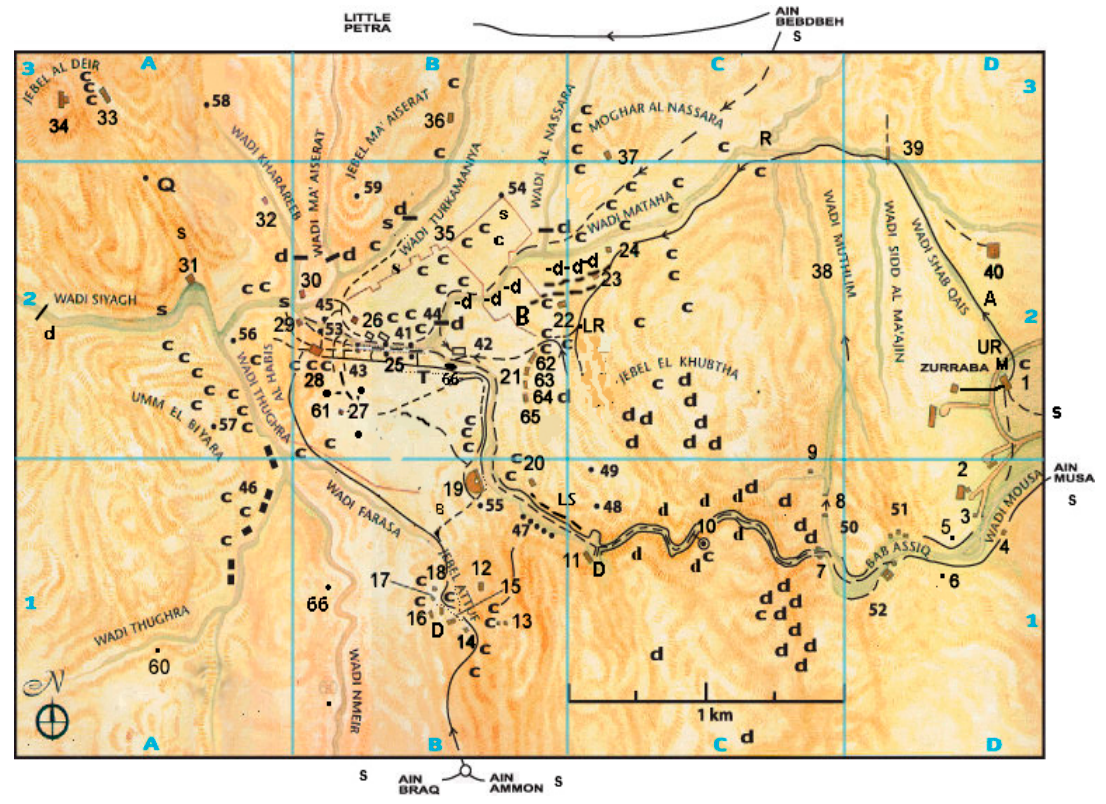
Figure 1. Site map of Petra: Site names corresponding to numbers given in the Appendix.